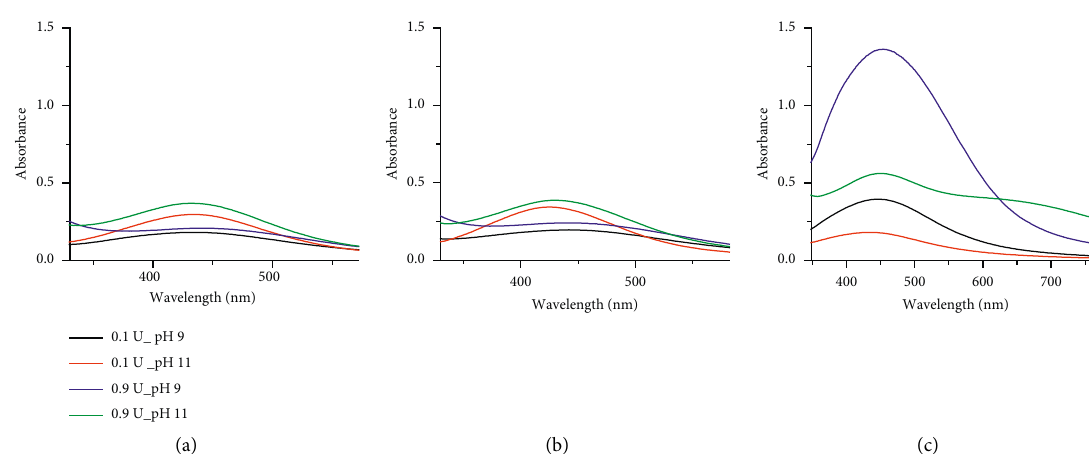
Figure 3: UV-Vis spectrum of Ag NPs obtained under 0.1g or 0.9 g of U. maydis at pH 9 and pH 11 after (a) 100 seconds of sunlight exposure at room temperature, (b) 100 seconds of sunlight exposure and 10min of reaction in the dark, and (c) 100 seconds of sunlight exposure and 6 days of reaction in the dark.